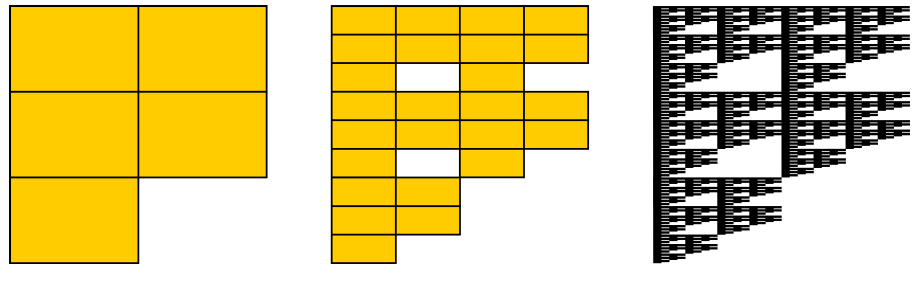
Figure 2: First, second, and fifth iterations of a Bedford-McMullen carpet Σ that is a self-affine (1/ s ) -Hölder curve (with H s ( Σ ) = 0 ) precisely when s ≥ log (5) > 2 2